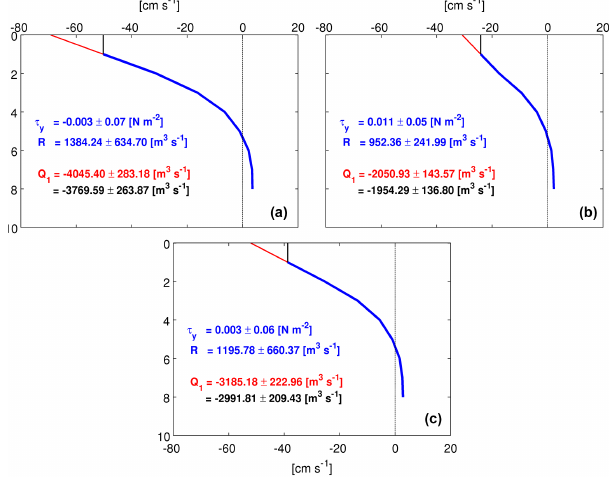
Figure 7. Mean profiles of along-fjord currents ( v ) at the mouth for the periods of winter (a) , spring (b) and for the entire period of measurement shown in Fig. 6. The blue line indicates the observed mean, which is lacking near the surface. The red and black lines indicate two different extrapolations to the surface: linear (red) and nearest (blue). The mean volume fluxes ( Q 1 ) obtained using the two extrapolations are included. Additionally, the averages of τ y for each period and the discharge ( R ) have been